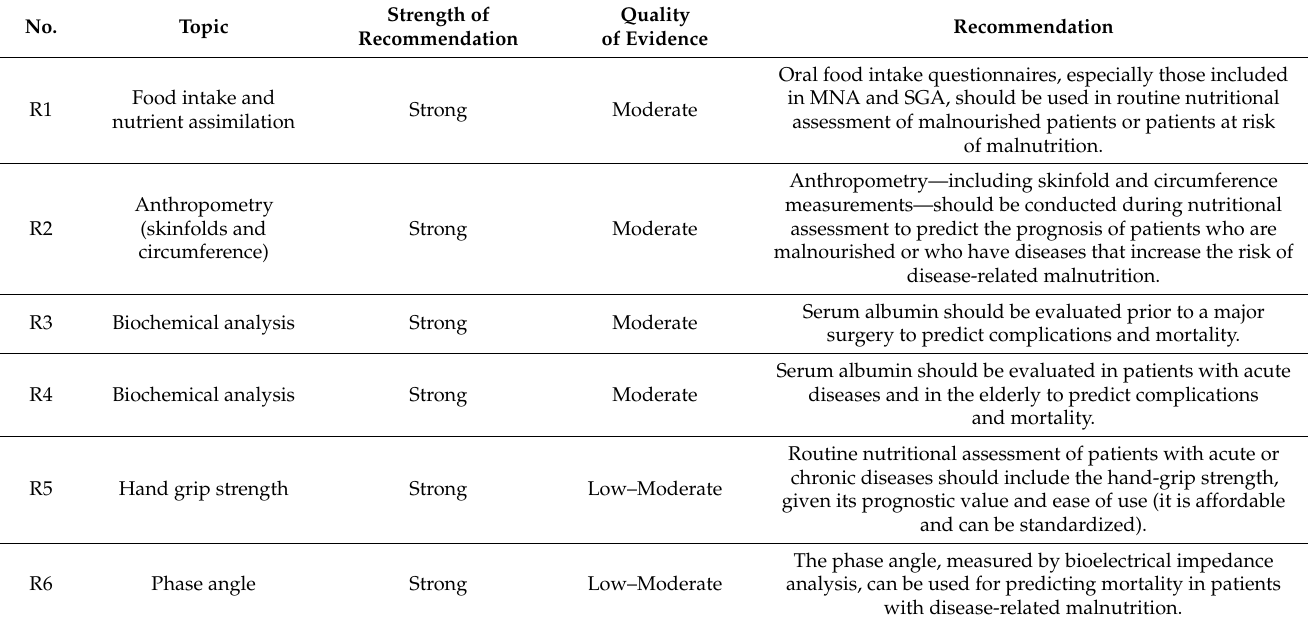
Table 1. Evidence-based recommendations following GRADE method for patients who are hospital- ized or receiving outpatient